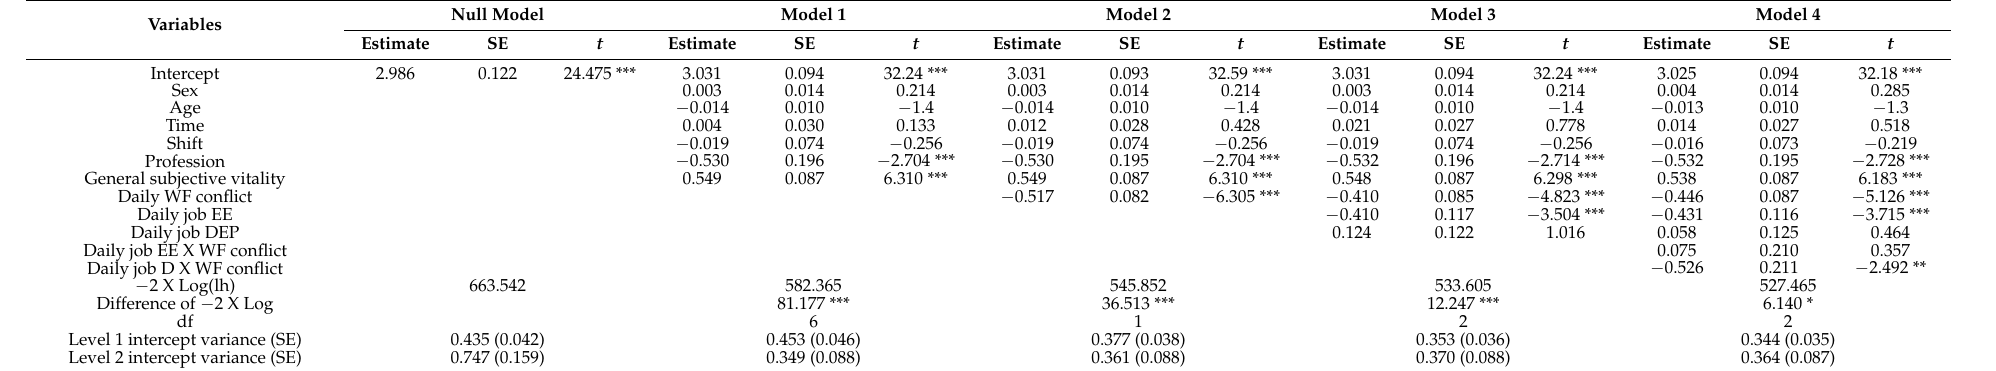
Table 3. Multilevel estimates for models predicting daily subjective vitality ( N = 56 × 5 days = 280 statistical